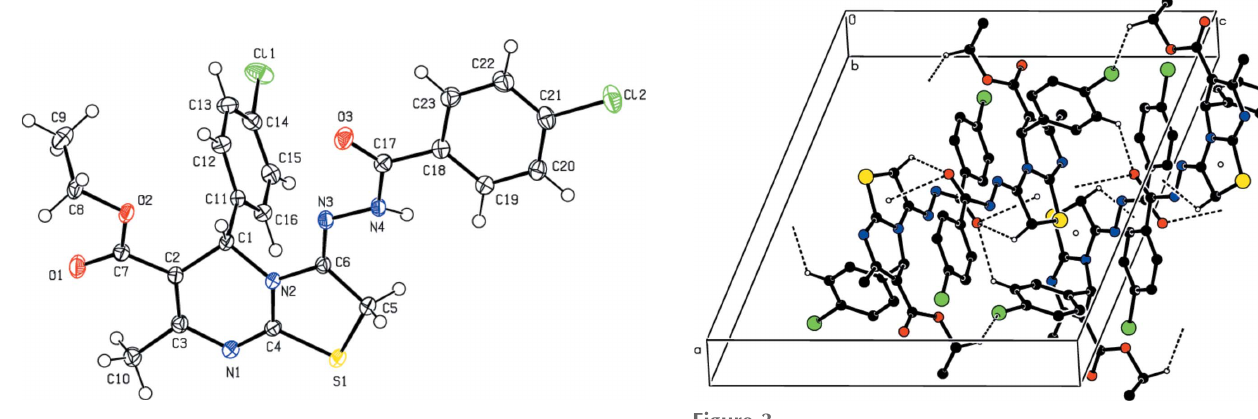
Figure 1 The title molecule with the labelling scheme and 50% probability